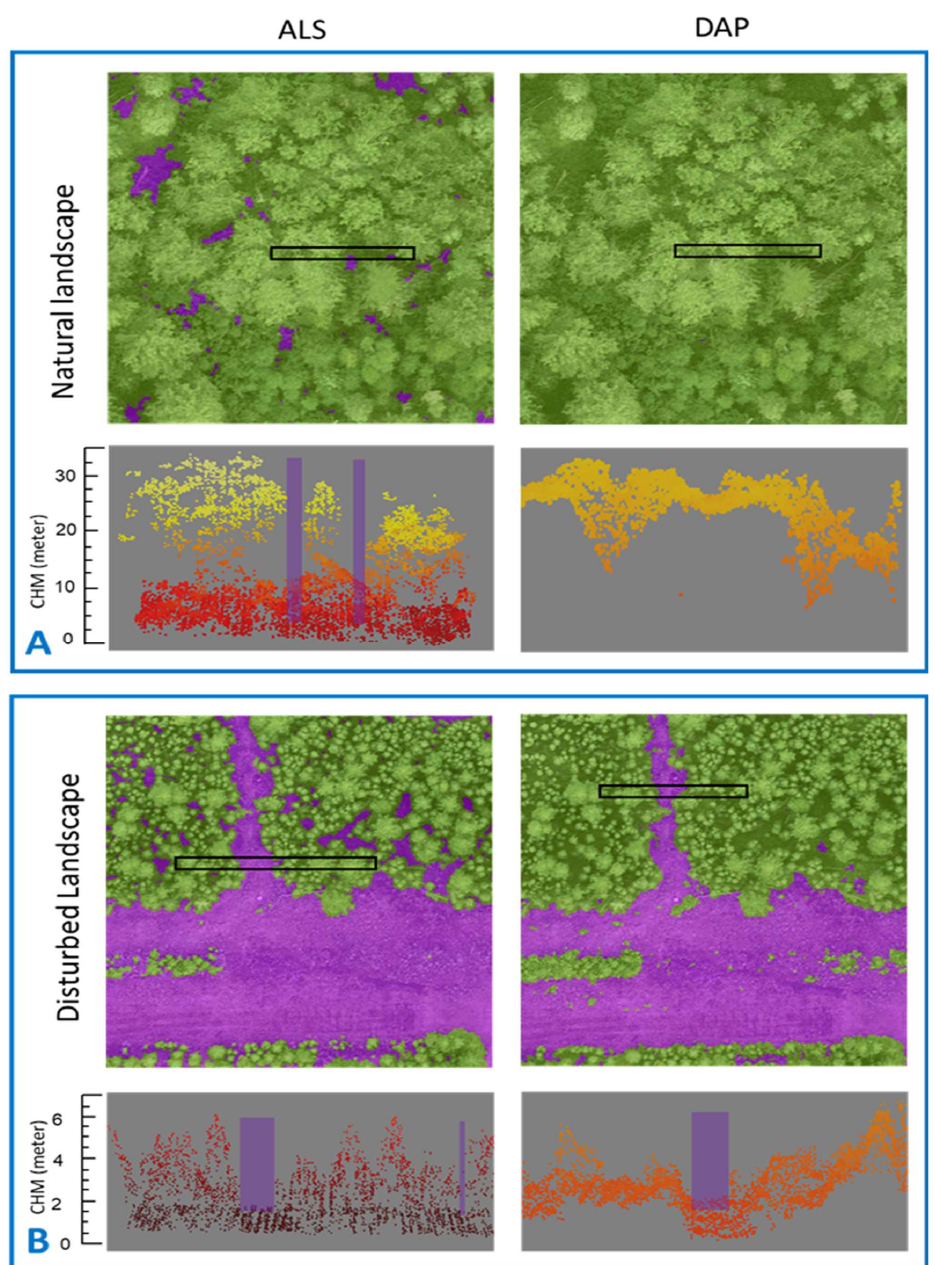
Figure 9. A visual comparison between LiDAR and DAP opening map segments in the study area. In the map segments, the purple areas represent pixels classified as opening by the respective approach, whereas the trees visibility is enhanced by using a green overlay. Black rectangles in each map segments represent an area for which corresponding vertical profiles of original elevation data (point cloud) are displayed below. Figure 6A displays a sample area in natural landscape where small openings are picked up by LiDAR (left) but not by DAP (right). Figure 6B represents a sample area in disturbed landscape where roads and seismic lines are more or less perfectly detected by both techniques. However, the LiDAR data identify other smaller openings in the surrounding landscape that DAP does not identify.